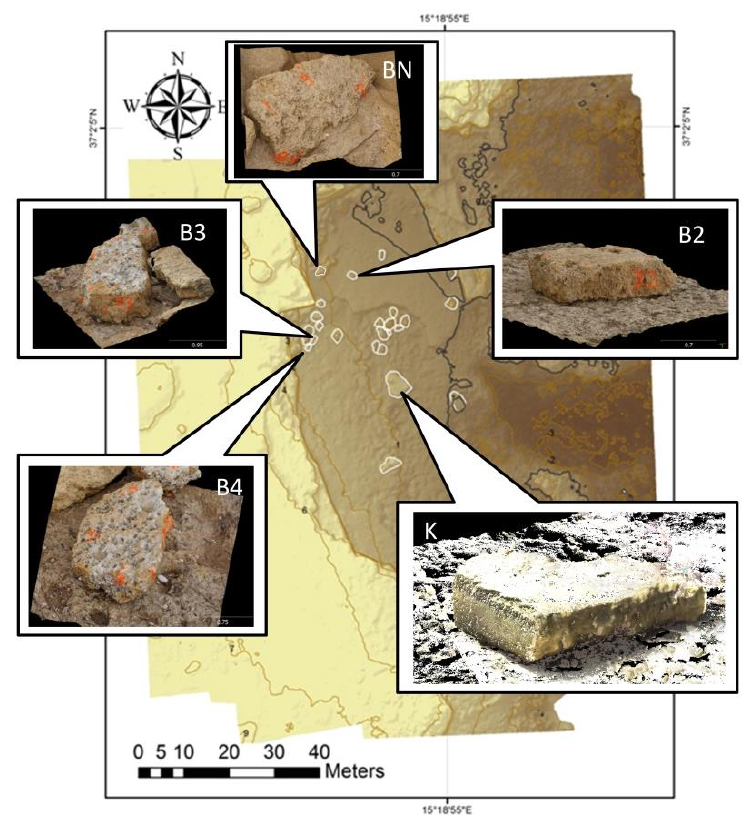
Figure 12. Morpho-topography of the shore-platform showing the boulders features assessed through photogrammetric (B2, B3, B4, BN) and Terrestrial Laser Scanner (TLS) (K) surveys.